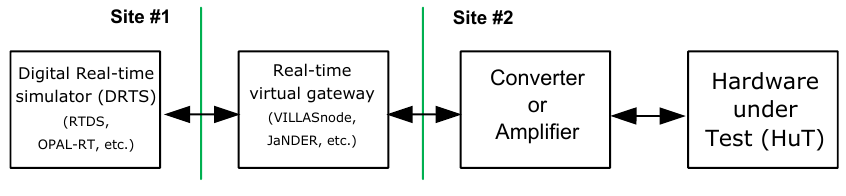
Figure 1. The general GD-PHiL